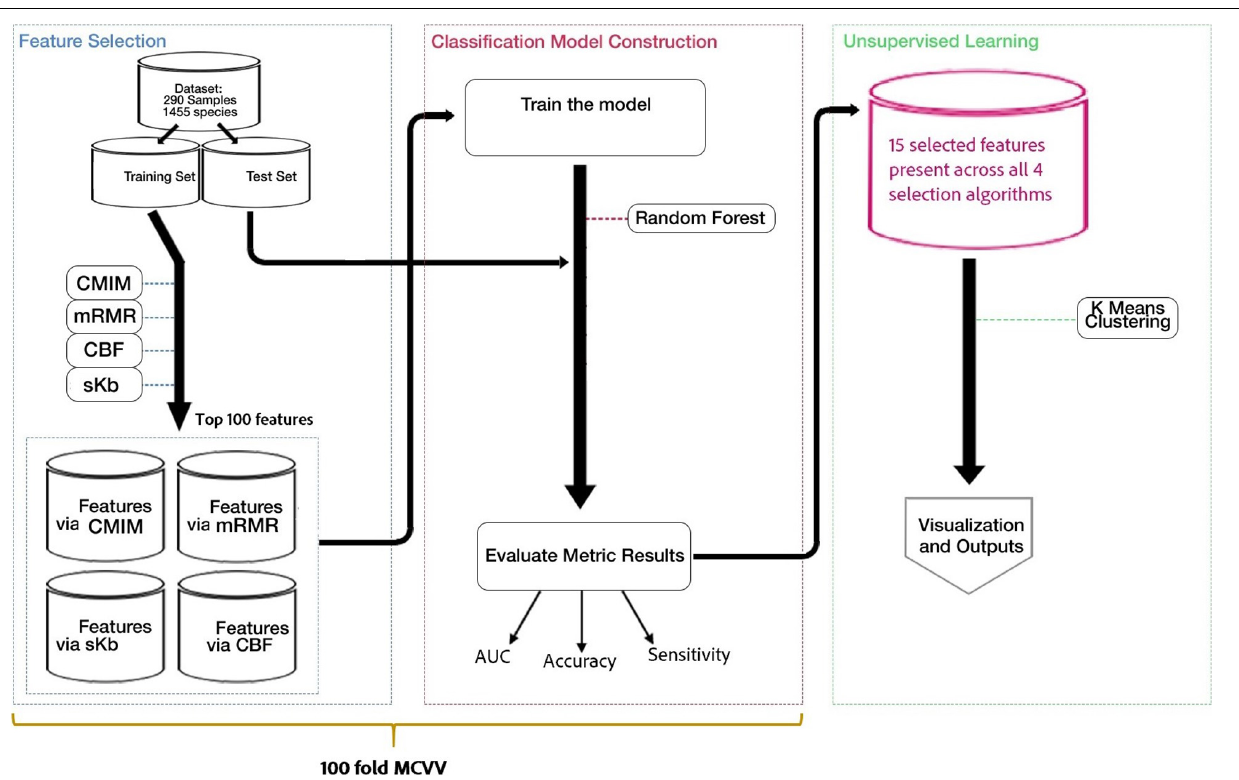
(Fleuret, 2004), FCBF (Senliol et al., 2008), and SKB